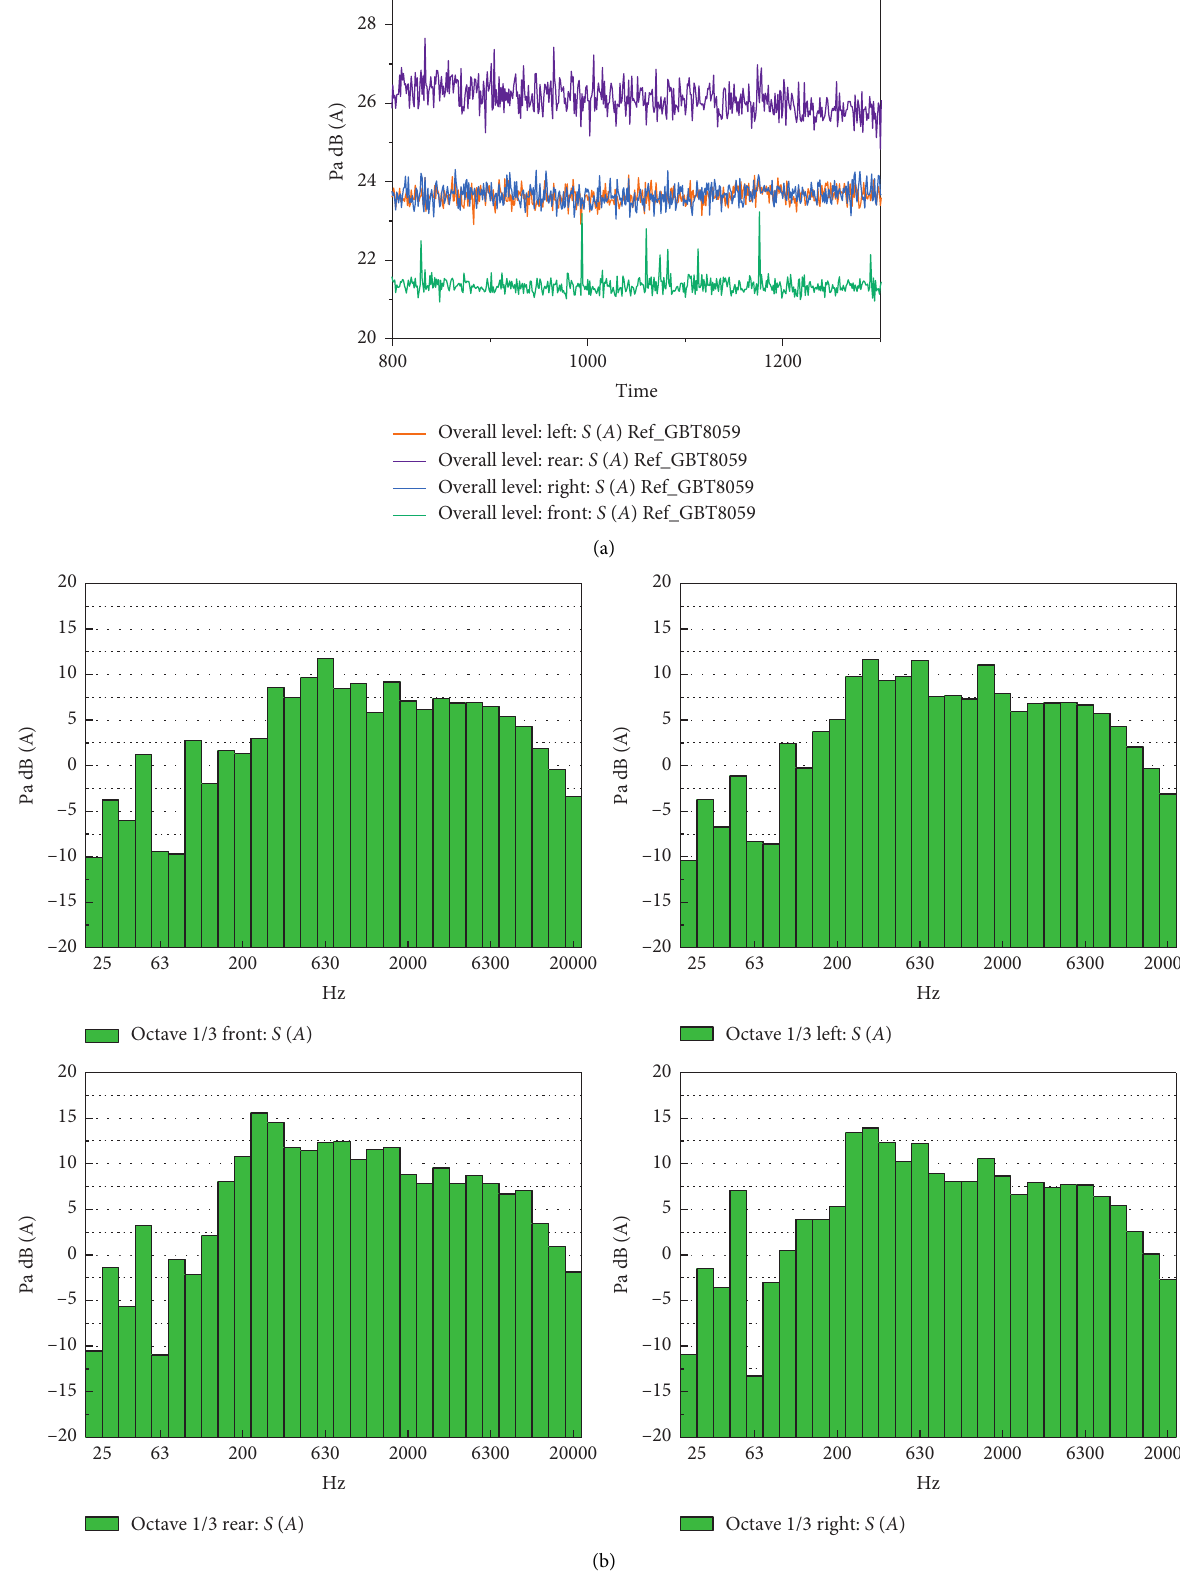
Figure 7: (a) Noise curves of running cycle of the refrigerator before improvement. (b) Noise spectrum distribution of running cycle of the refrigerator after